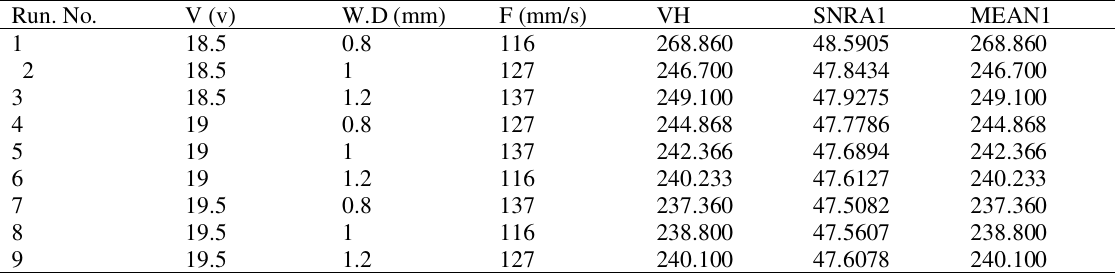
Response for Signal to Noise Ratios for VH Larger is the Best Level V (v) WD